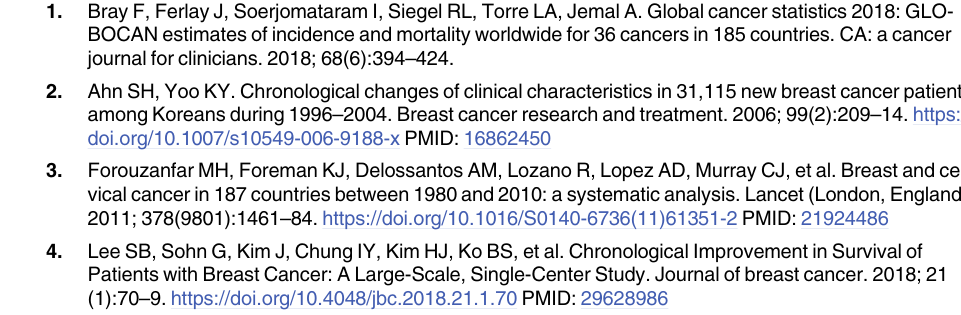
S1 Fig. Chronological changes of distant metastasis-free survival (DMFS) in Korean breast cancer patients according to the subtype. (A) HR+/HER2–. (B) HR+/HER2+. (C) HR–/ HER2+. (D) HR–/HER2–. HR: hormone receptor; HER2: human epidermal growth factor receptor